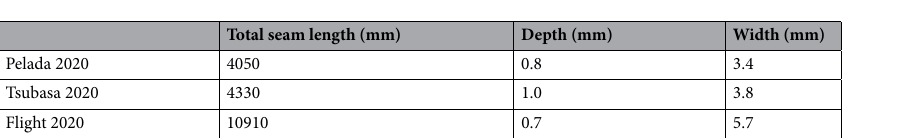
Table 1. Extended total length of the panel seam (bonds and grooves), groove depth, and groove width on the ball surface.